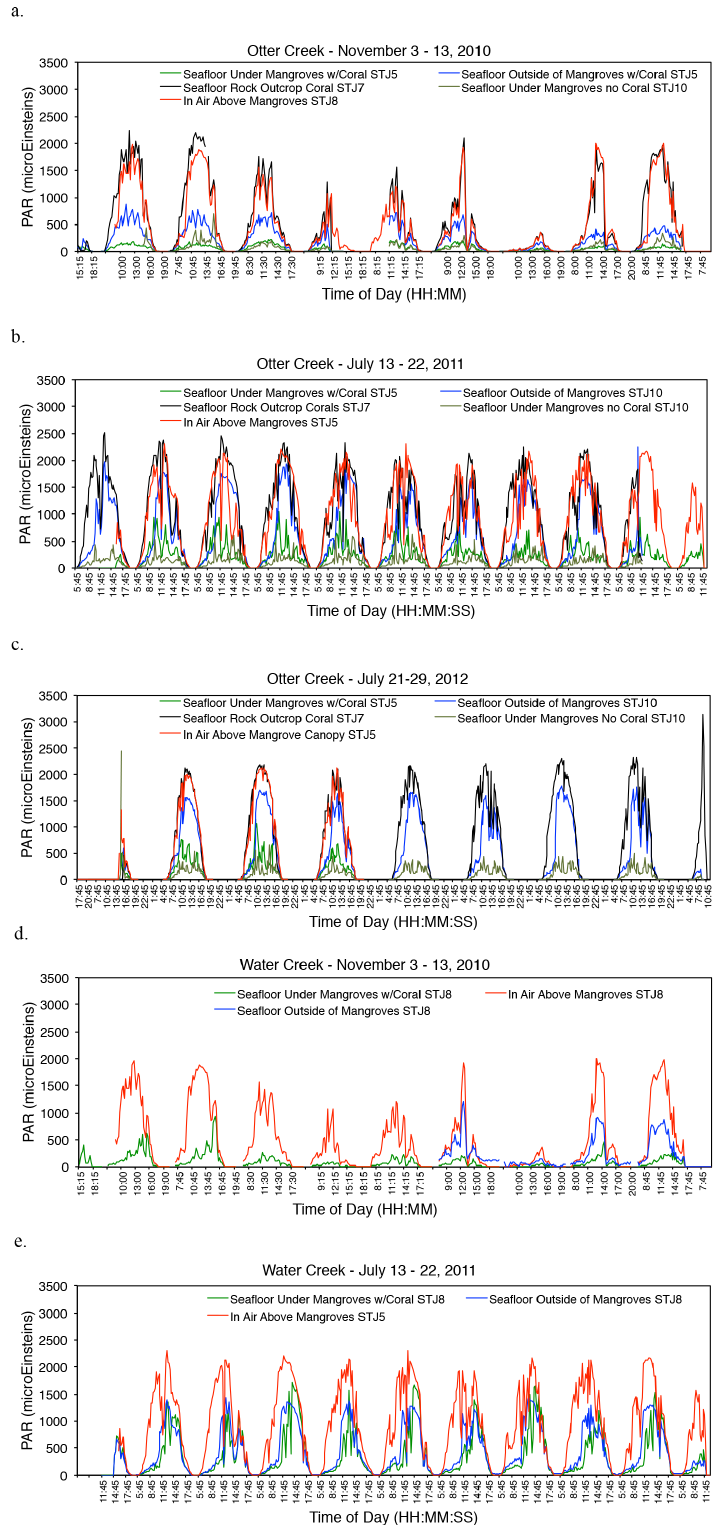
Figure 7. Photosynthetically active radiation (PAR) measurements at study sites in Otter Creek ( a , b , and c ) and Water Creek ( d and e ). Measurements represent 15min averages. STJ numerals indicate PAR sensor locations as referenced in Fig. 1. Data available at http: